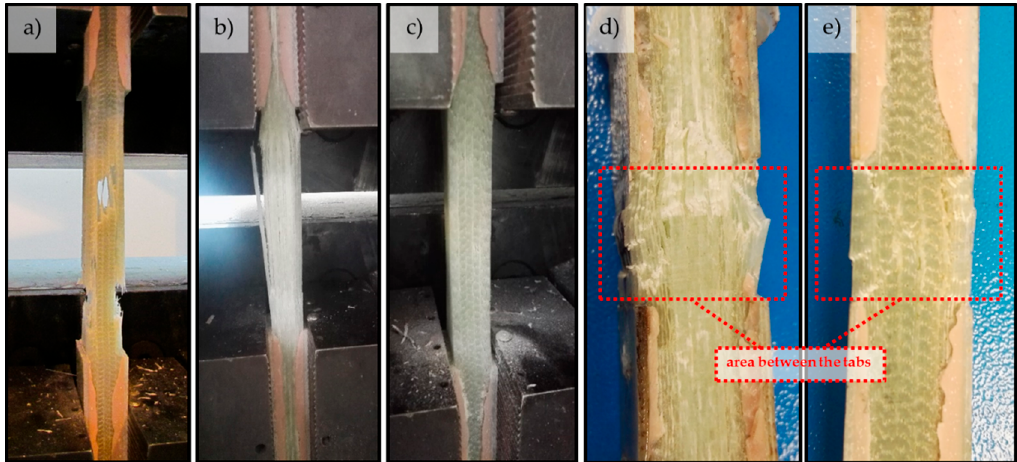
Figure 8. Examples of failure modes of GFRP face specimens in tension ( a ) perpendicularly and ( b ) transversally to the